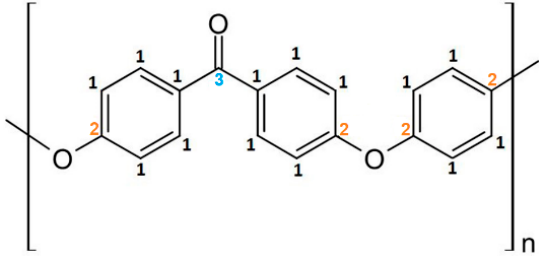
Figure 3. Chemical structure of PEEK’s mer.